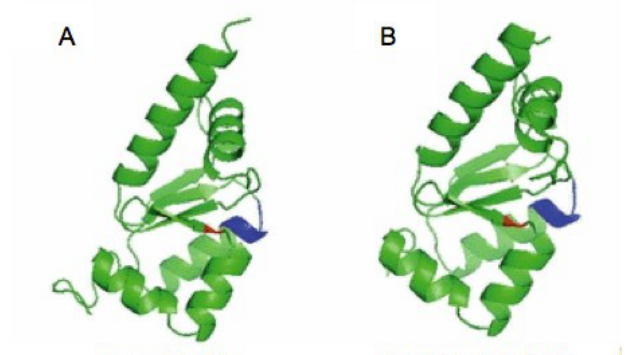
Figure 2. Structural characterization of plant GRXs. ( A ) Ribbon representation of poplar GRXC1. Four central β-sheets are surrounded by five α-helices. The position of the conserved glycine in the GSH binding site is indicated in red, and the CGYC active site is blue. ( B ) Ribbon representation of Arabidopsis ROXY1 obtained by homology modeling using poplar GRXC1 as a template. The conserved glycine (G110, red) and the CCMC active site (blue) are respectively located on the same β-sheet and α-helix as in poplar GRXC1. Adapted from